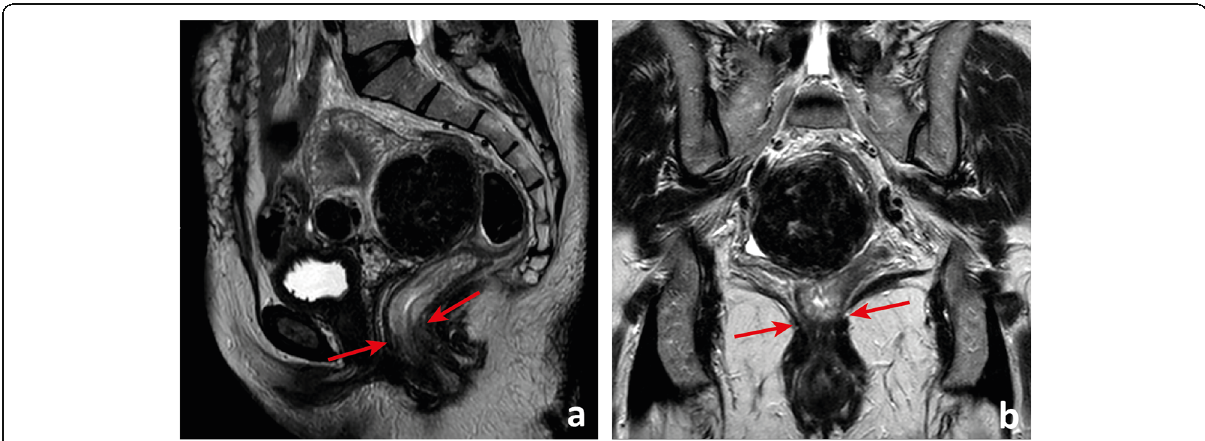
Fig. 1 The anorectal transition may be defined by the upper limit of the internal sphincter of the anus (between arrows in a ), which is generally much thicker than the inner muscular layer of the muscularis propria of the rectum, or by the plane that intersects the superior border of the puborectalis muscle (between arrows in b ), which may be asymmetric, as in the example